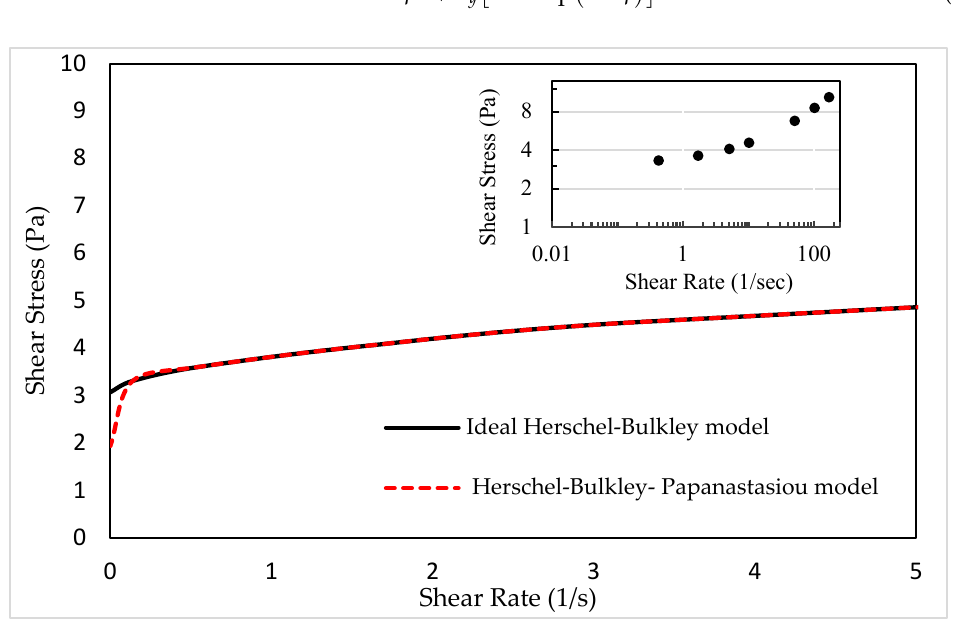
Figure 4. Shear stress vs. shear rate for BXG4 fluid according to the exponential model proposed by Papanastasiou [51].